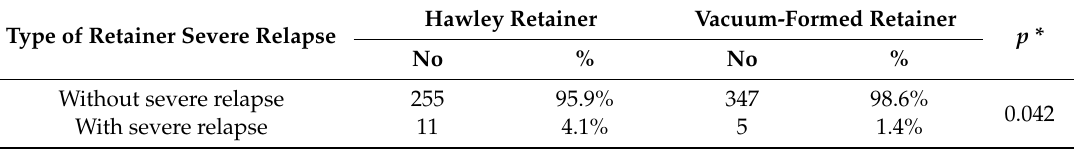
Table 9. Distribution of the patients according to the existence of severe relapse and type of retainer.